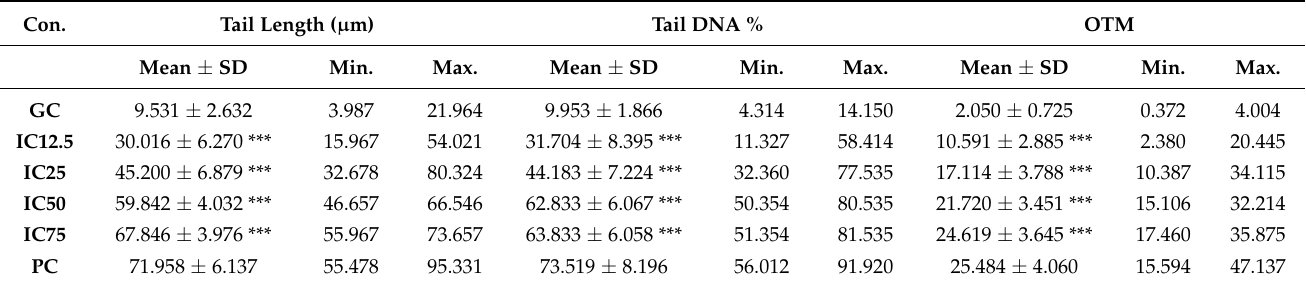
Table 2. Results of genotoxicity from comet assay.